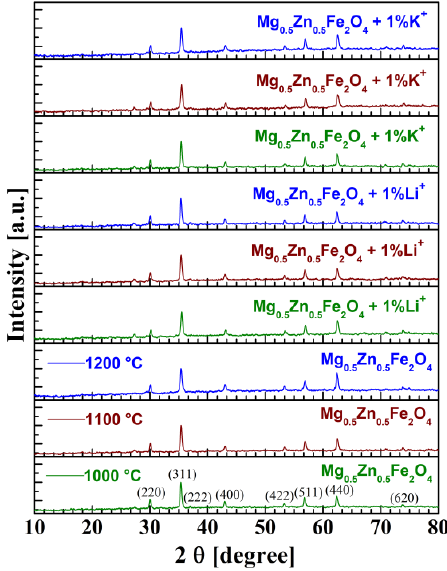
Figure 1. XRD patterns of magnesium-zinc